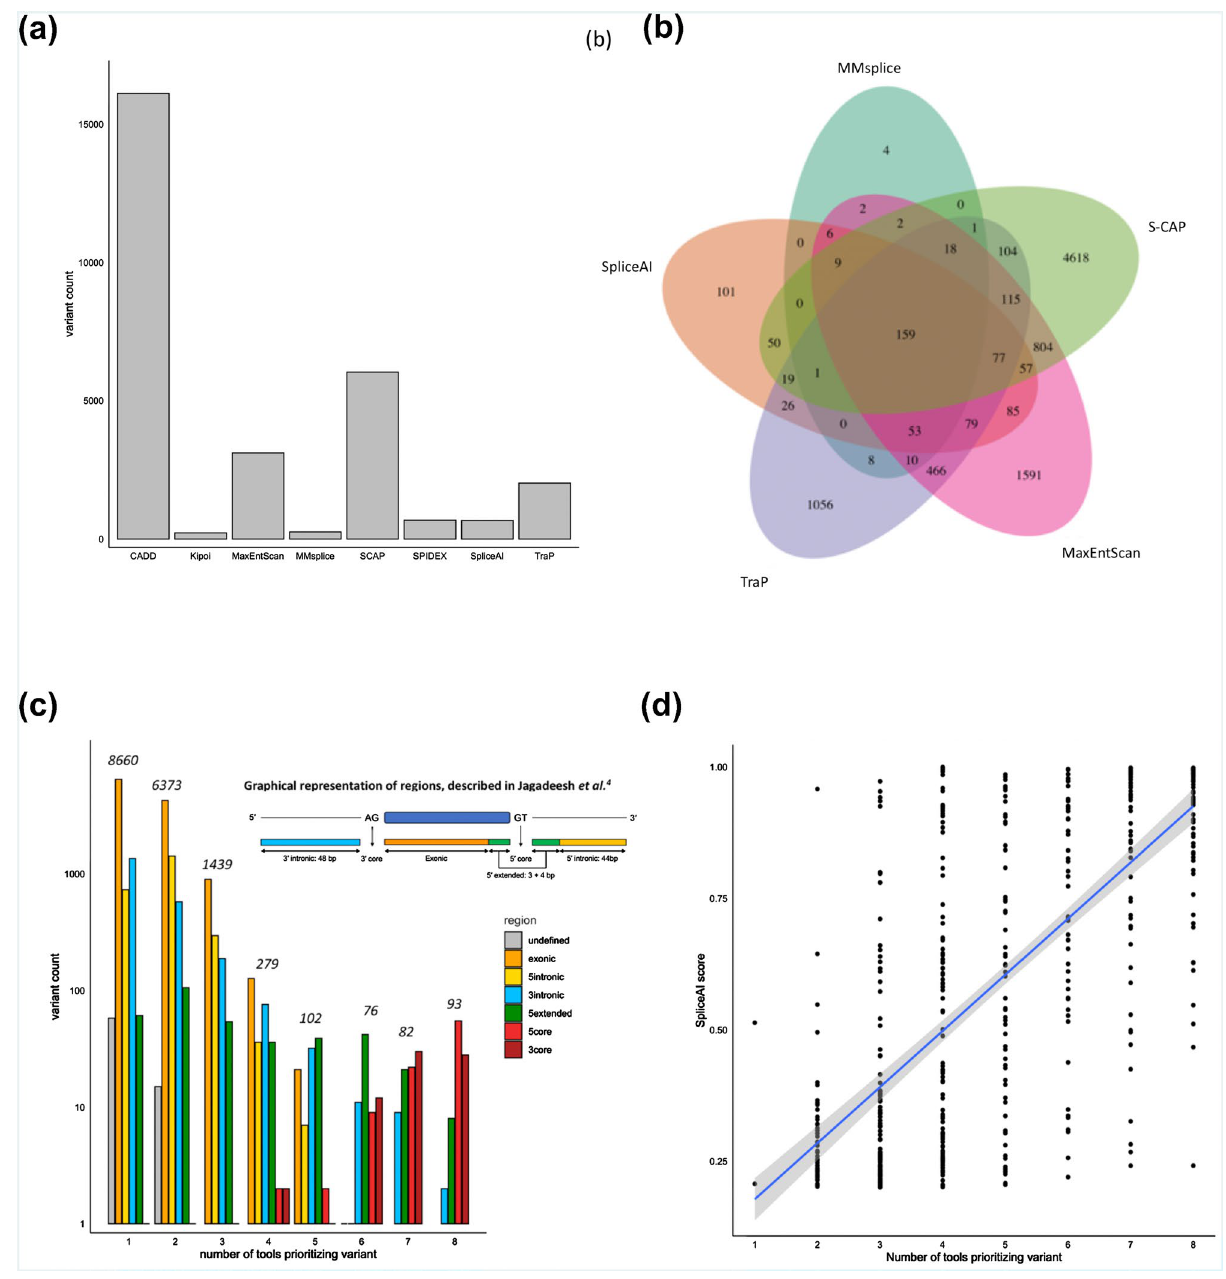
Figure 3. Summary of the overlap and correlations observed between the scores from in silico splicing prediction algorithms for 18,013 unique rare variants identified in a large cohort of 2783 individuals with rare disease undergoing genetic testing, specifically for syndromic and non-syndromic inherited retinal disorders. ( a ) Bar chart showing overall count of unique variants prioritized using pre-defined thresholds for each in silico prediction algorithm; ( b ) Overlap between the unique variants prioritized by the five most correlated in silico prediction tools; ( c ) Grouped bar chart demonstrating the overlap of variants prioritized by each tool segregated by the region of the genome that the variant impacts, as defined by Jagadeesh et al. 16 , demonstrating that variants prioritized by many tools are highly likely to be close the canonical splice sites (5 ′ core, 3 ′ core and 5 ′ extended); ( d ) Correlation between SpliceAI score and the number of additional tools also prioritizing the variant for the 528 unique rare variants prioritized by